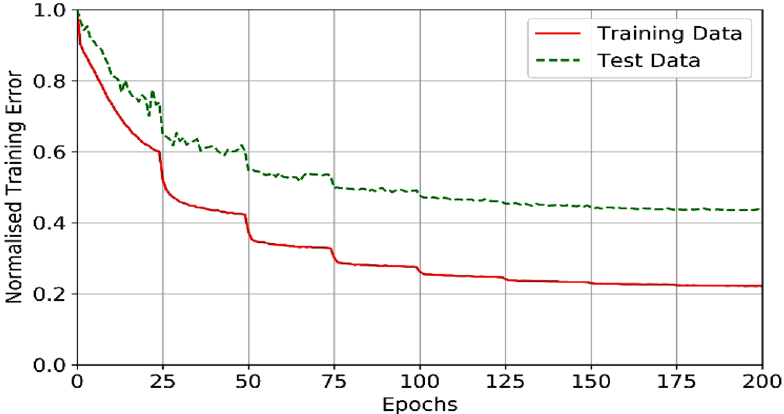
Figure 3. Training error for one of the network learning runs. Here the training data were generated using 20,000 simulations and 500 simulations used for the test